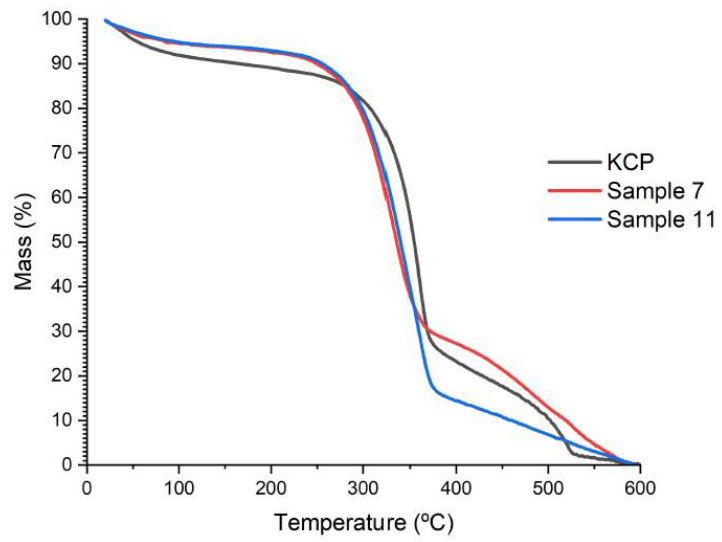
Figure 4. Evaluation of the thermal decomposition of KCP and CNF samples by TGA.